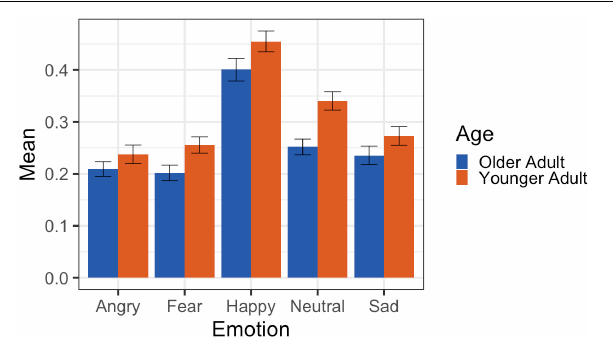
FIGURE 2 | Participant response means and 95% CIs for Study 3 approach/avoid mouse placement task. Y -axis represents relative size of the stimulus, with smaller values indicating the stimulus being placed further away. Placement values range from 1 (largest size) to 0 (smallest